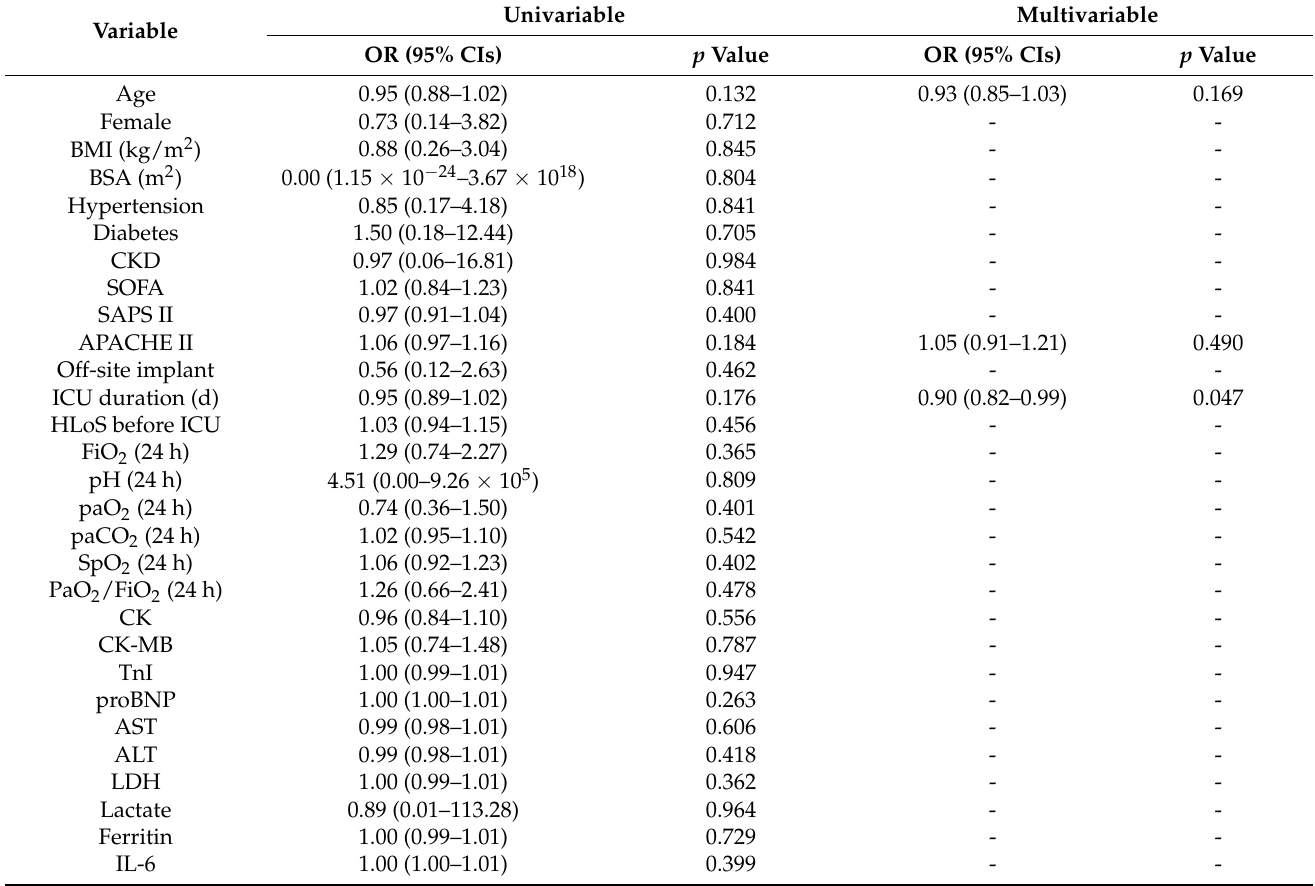
Table A1. Univariable and multivariable analysis. Predictors of ECMO